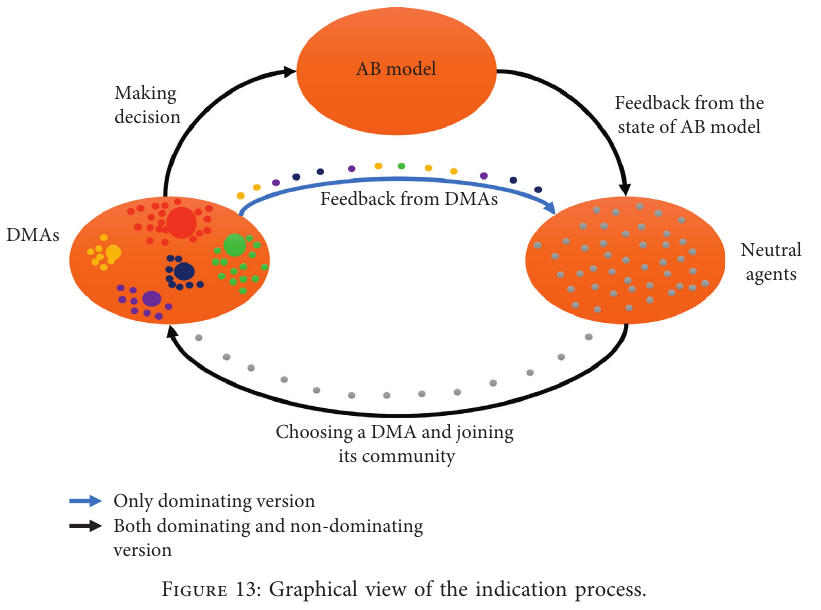
Figure 13: Graphical view of the indication